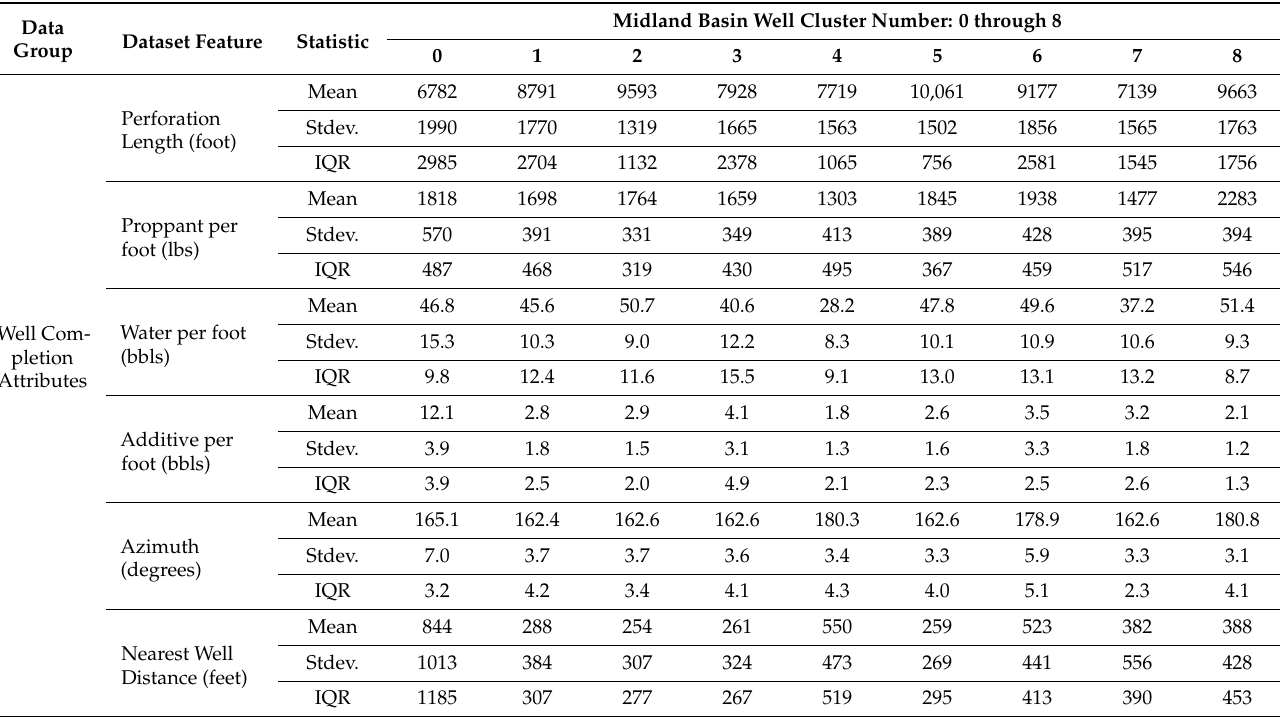
Table A2. Inventory of descriptive statics, 1st year, and cumulative 5-year production estimates for a hypothetical representative well within each Midland Basin Well